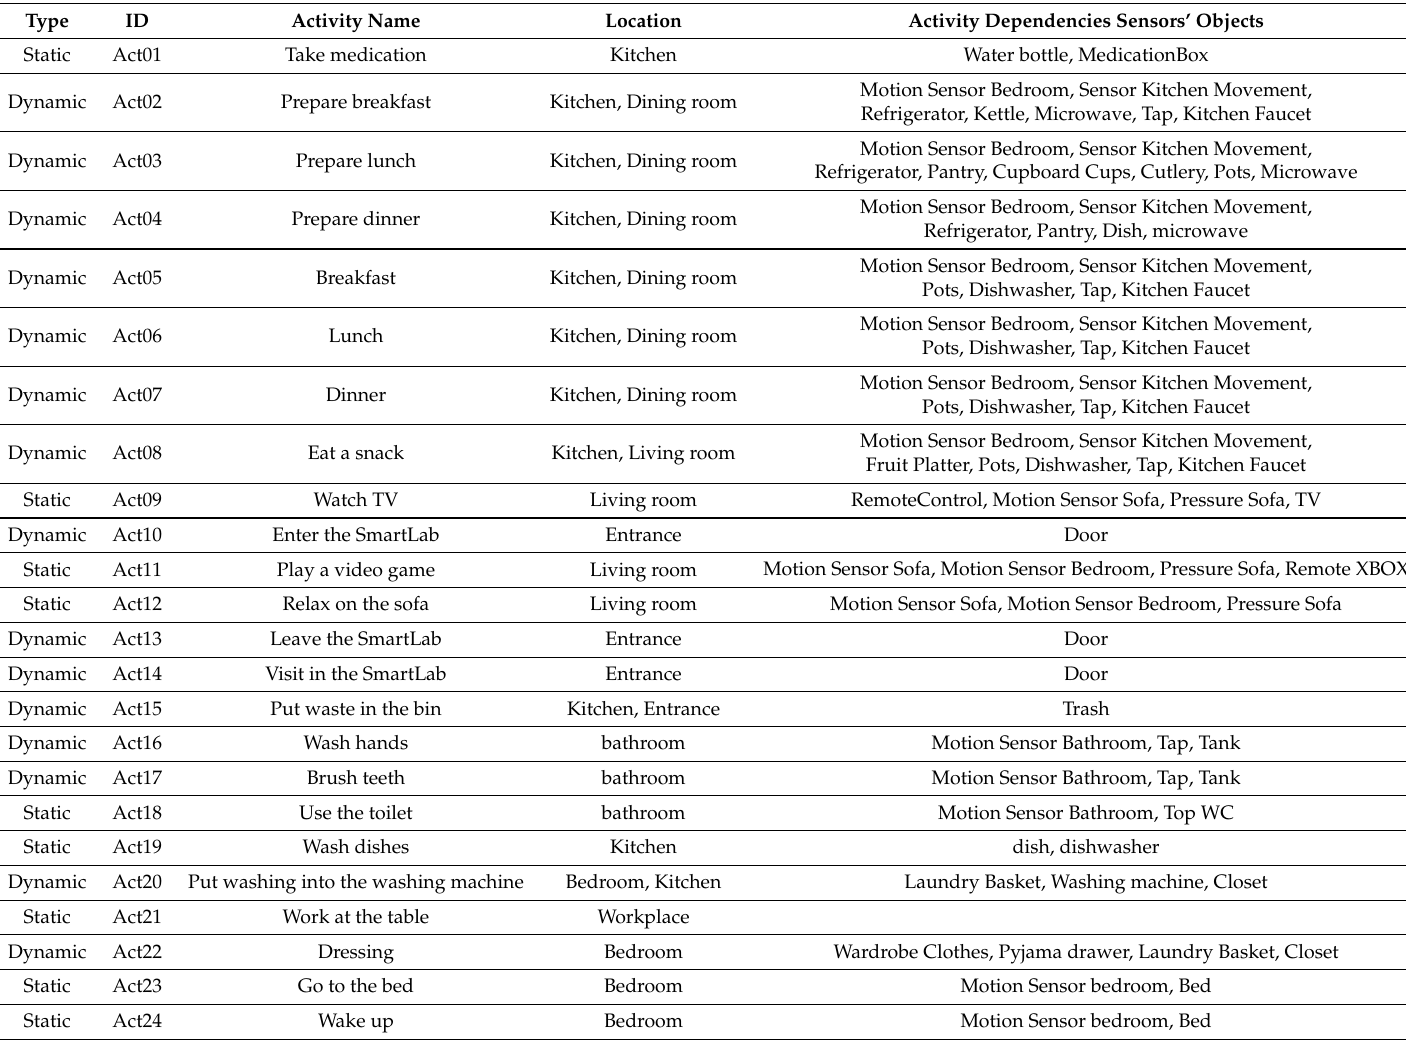
Table 1. A list of activities, locations, and dependent sensor objects identified from UCamI dataset utilized for SemImputOnt